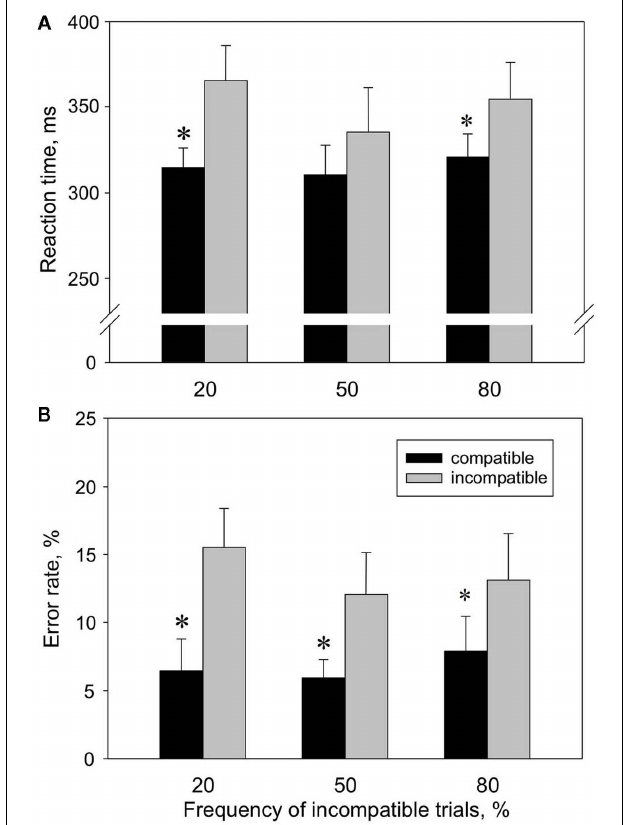
FIGURE 3 | Reaction times (A) and error rates (B) in compatible (black) versus incompatible (gray) trials at different conflict probabilities, measured in the behavioral block. Values shown are means ± SEM ( n =